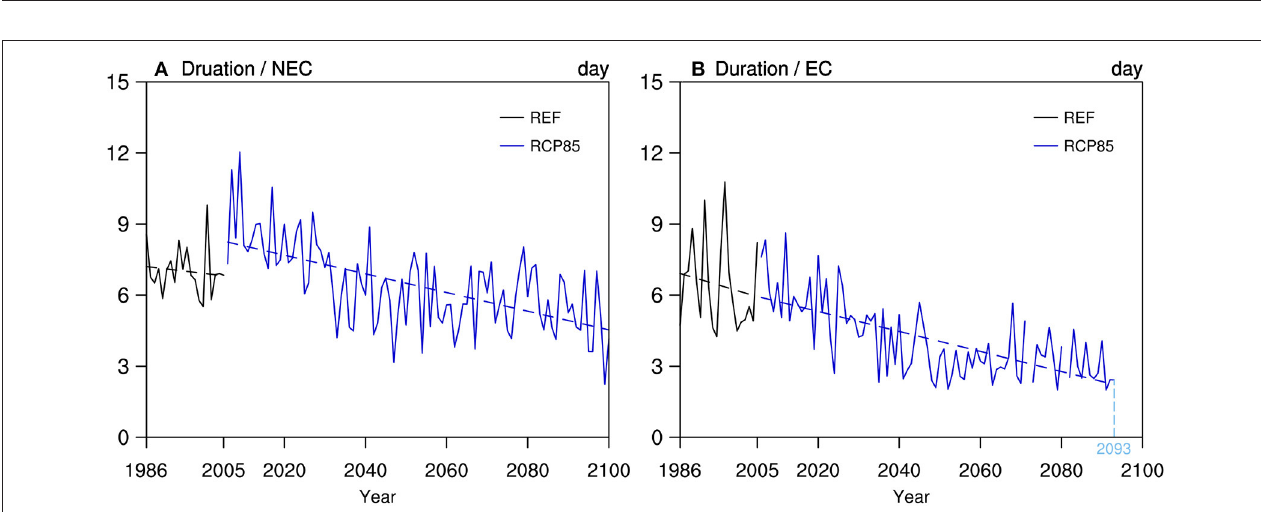
FIGURE 11 | Time series of chilling damage duration (unit: day) for reference (1986–2005) and future projection (2006–2100) by LMDZ-MME averaged over (A) Northeast China and (B) Central and East China. The black solid line indicates the historical simulation, and the blue solid line indicates the projection results under the RCP8.5 scenario; the dotted line indicates the linear regressions. The vertical light blue line and corresponding year represents the last time of event